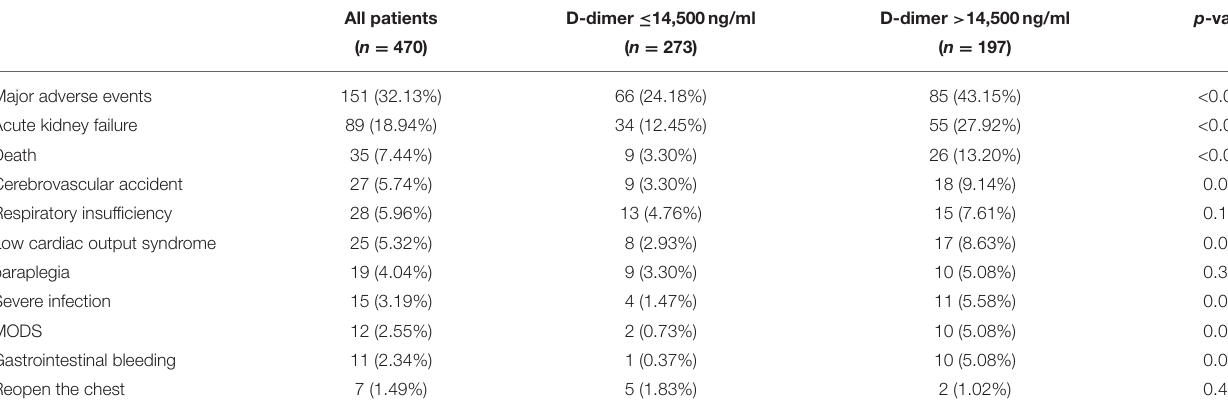
TABLE 2 | In-hospital MAE patients with ATAAD.